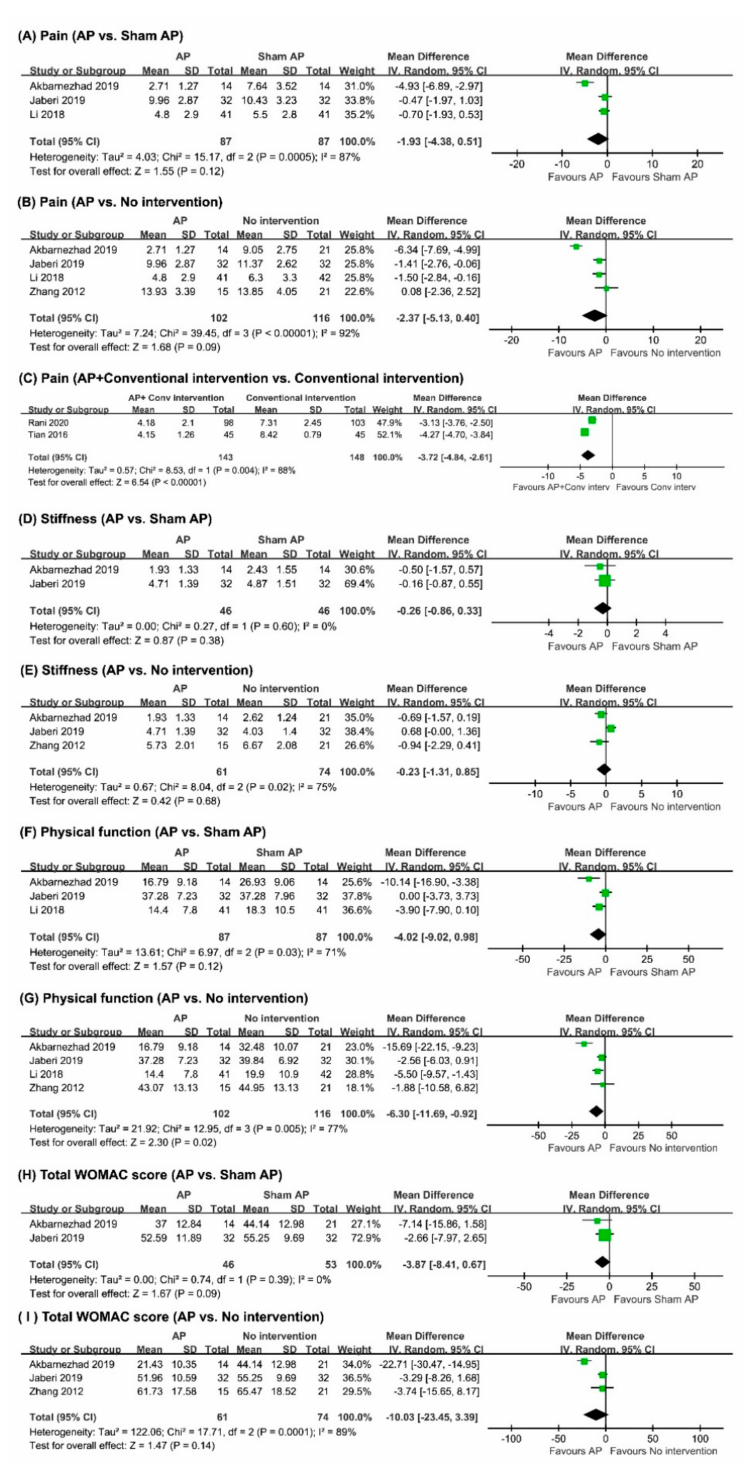
Figure 3. Forest plot of ( A ) pain (acupressure vs. sham acupressure); ( B ) pain (acupressure vs. no intervention); ( C ) pain (acupressure plus conventional intervention vs. conventional intervention) ( D ) stiffness (acupressure vs. sham acupressure) ( E ) stiffness (acupressure vs. no intervention); ( F ) physical function (acupressure vs. sham acupressure); ( G ) physical function (acupressure vs. no intervention); ( H ) total WOMAC score (acupressure vs. sham acupressure); ( I ) total WOMAC score (acupressure vs. no intervention). AP: acupressure; CI: conventional